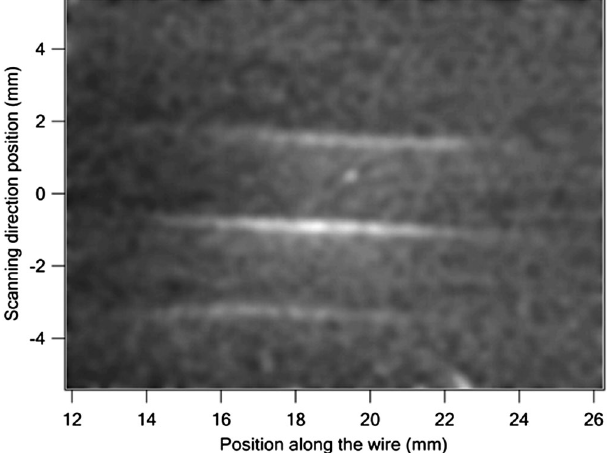
FIG. 6. Three images of the wire moving at a scanning speed of 20 m = s. Movement is in the upward direction, and the laser pulse frequency is 8 kHz. The wires are attached to the rotating blade on the left.